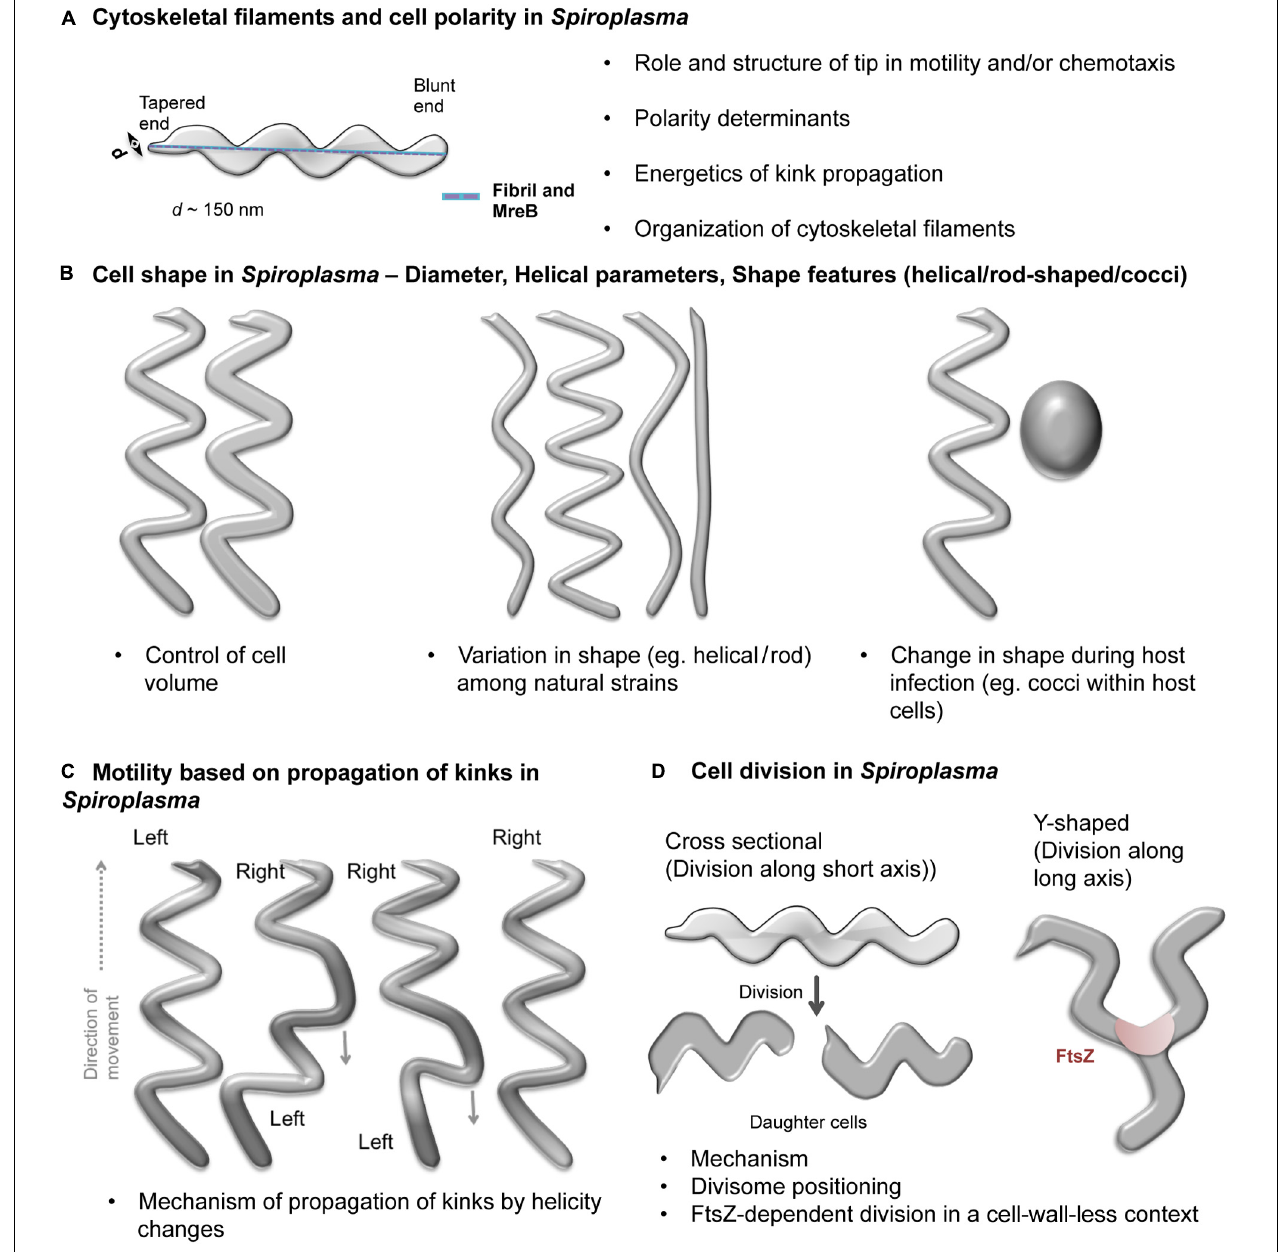
FIGURE 2 | Schematic representations of open questions in Spiroplasma biology. Open questions in Spiroplasma biology include- (A) Organization of cytoskeletal filaments and cell polarity determinants. A Spiroplasma cell showing its characteristic helical shape, distinct poles (one is tapered while the other is blunt) and cytoskeletal ribbon (blue) connecting the two poles through the shortest path along the cell body is shown. (B) Factors conferring spherical, rod and helical shapes, determinants of helical pitch and cell lengths in Spiroplasma. (C) Kinking-based motility in Spiroplasma . The kink is introduced at one of the poles by change in handedness of the cell and traverses through the cell body. Portions of the cell on either side of the kink have opposite handedness. (D) Modes of cell division (cross sectional and Y-shaped) and factors favoring them. The bulleted text in the figures summarizes the open